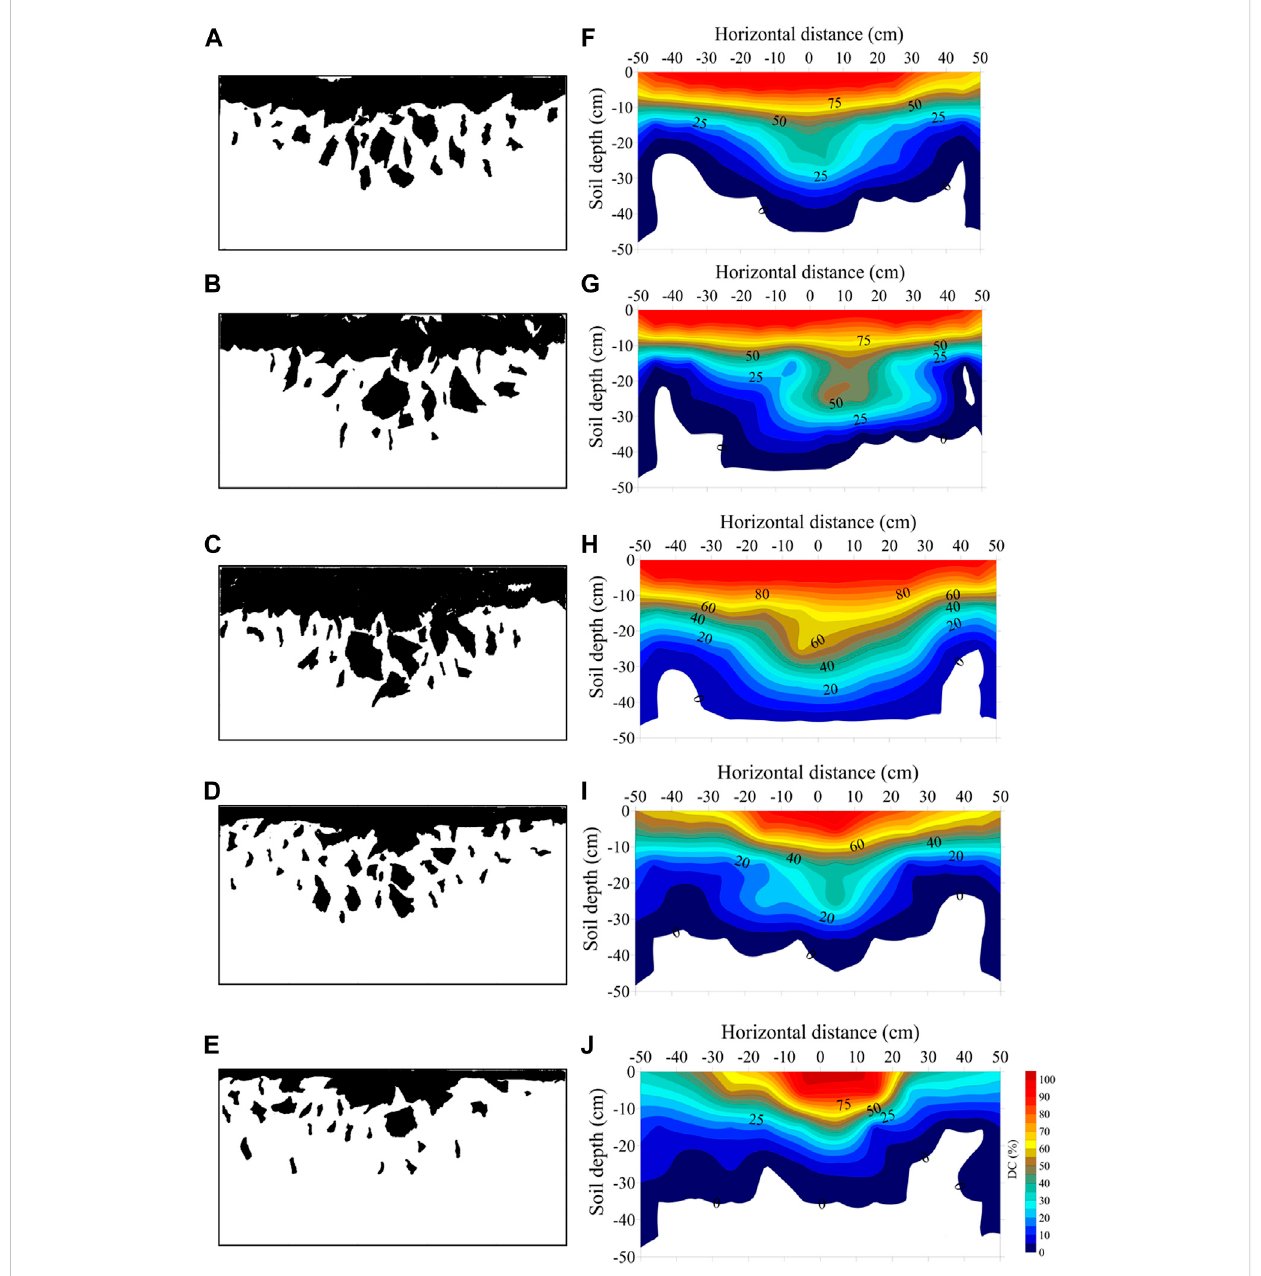
FIGURE 2 Binarized images and spatial distributions of dyed proportion for different stump heights. (A – E) Binarized images for stump heights of 0, 10, 15, and 20 cm, and no-stumping, respectively. (F – J) Spatial distributions of dyed area proportion for stump heights of 0, 10, 15, and 20 cm, and no-stumping,